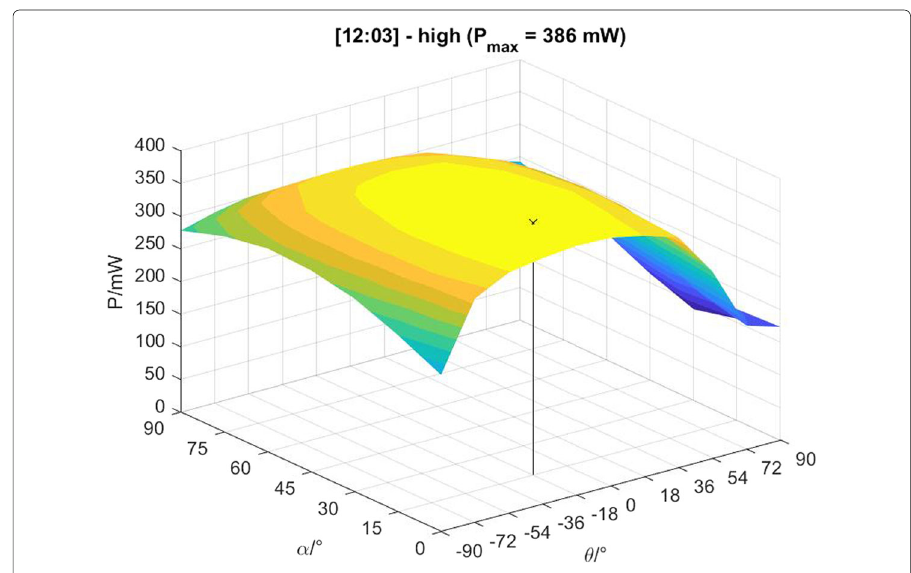
Fig. 8 Power distribution at high altitude